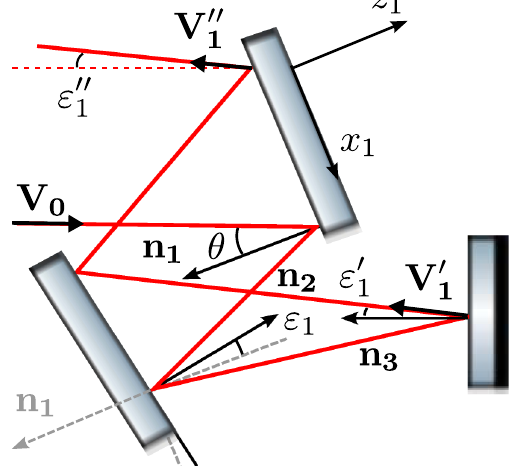
; FIG. 22. Schematic view of misaligned first MPS with the main